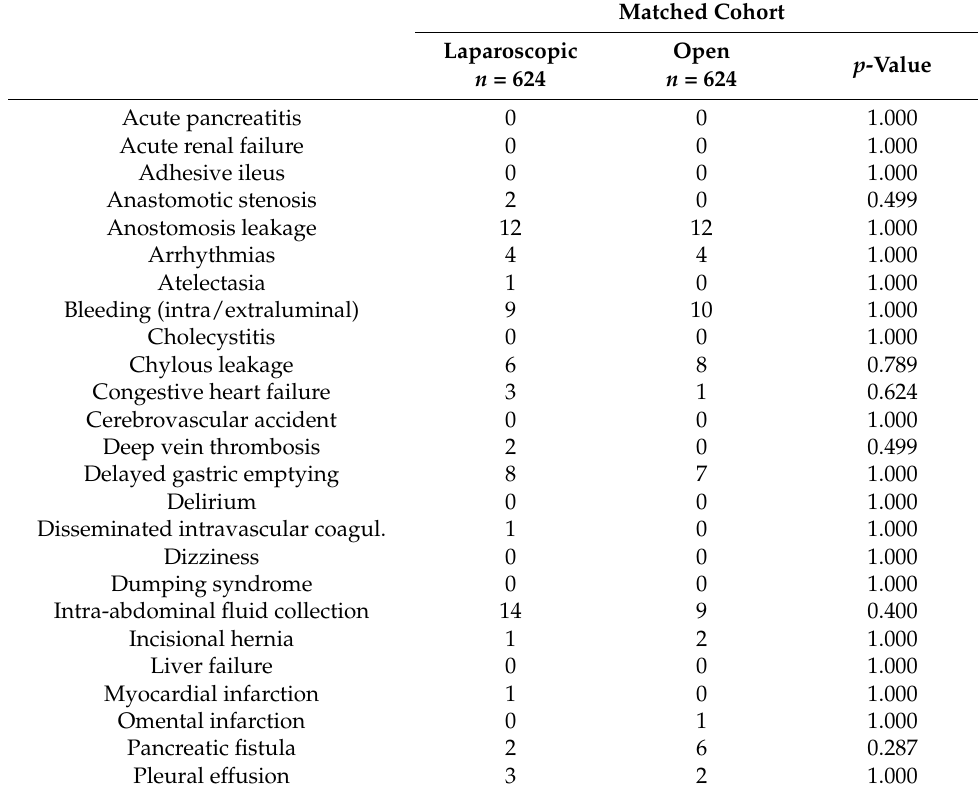
Table 3. In-hospital complications in the matched